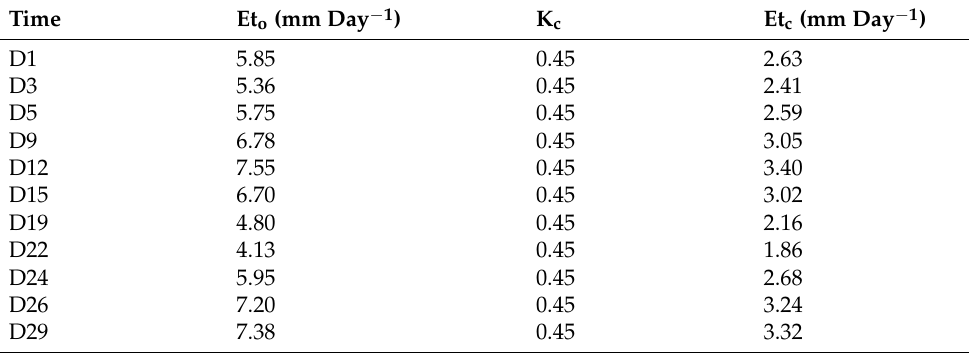
Table 1. Crop coefficients for irrigation water calculation during the experimental